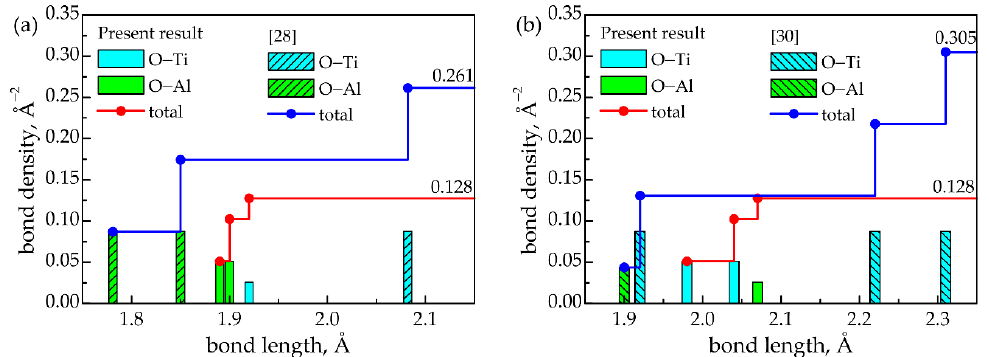
Figure 6. Bond density versus bond length at the TiAl / TiO 2 interface in the case of hollow configuration: ( a ) Al termination; ( b ) Ti termination.